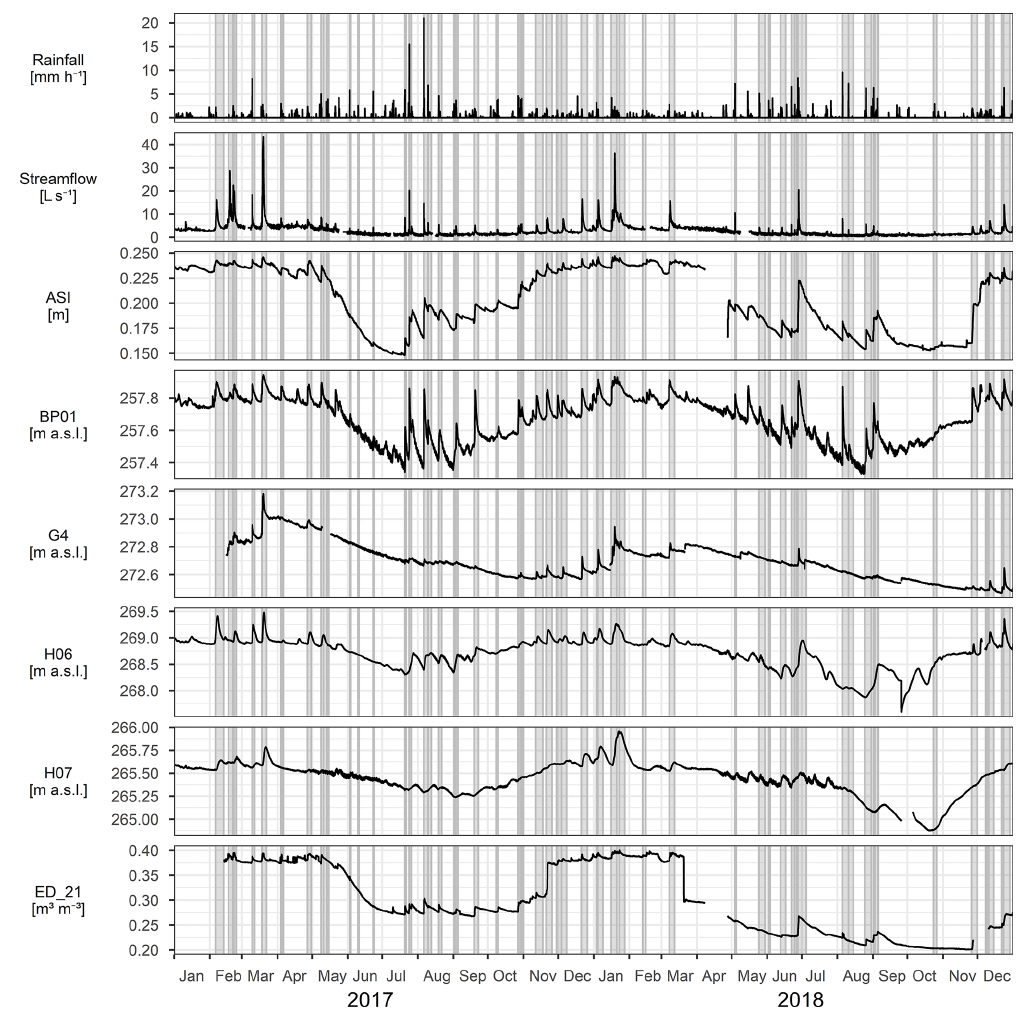
Figure 2. Dynamics of rainfall, streamflow at the catchment outlet, antecedent soil moisture index (ASI), groundwater (BP01, G4, H06, H07) and soil moisture (ED_21) during the investigation period, 2017–2018. The shaded areas represent the times of analysed